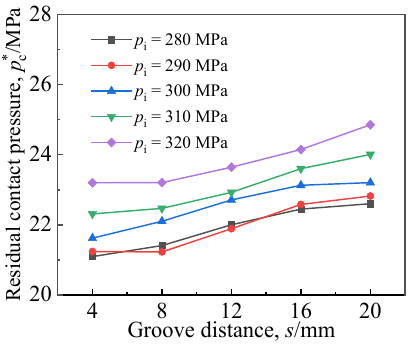
Figure 17. Effects of groove distance from the single groove in base to interface on residual contact pressure of joints.